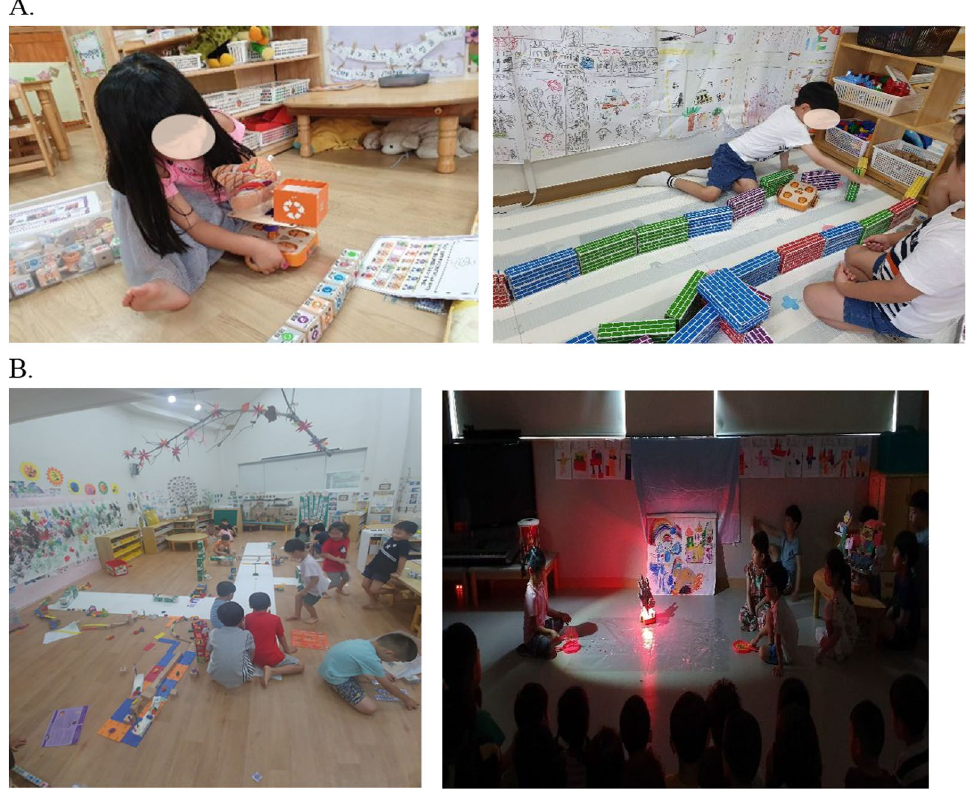
Fig. 1 Examples of the STEAM program using robotic kits integrated into the Nuri curriculum. A Examples of KIBO plays. B Examples of each class project in the final